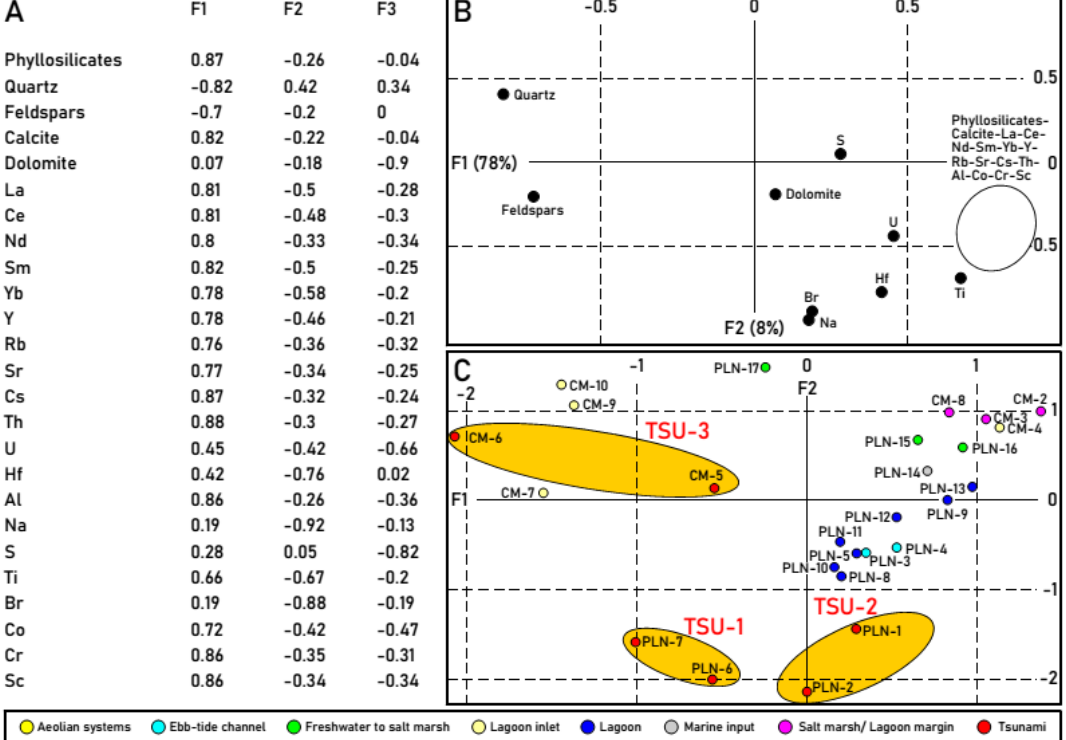
Figure 16. Factorial analysis: mineralogy vs geochemistry. ( A ) The rotated factor loadings (factor scores) of the three main factors; ( B ) variables: F1–F2 diagram; ( C ) samples: F1–F2 diagram.